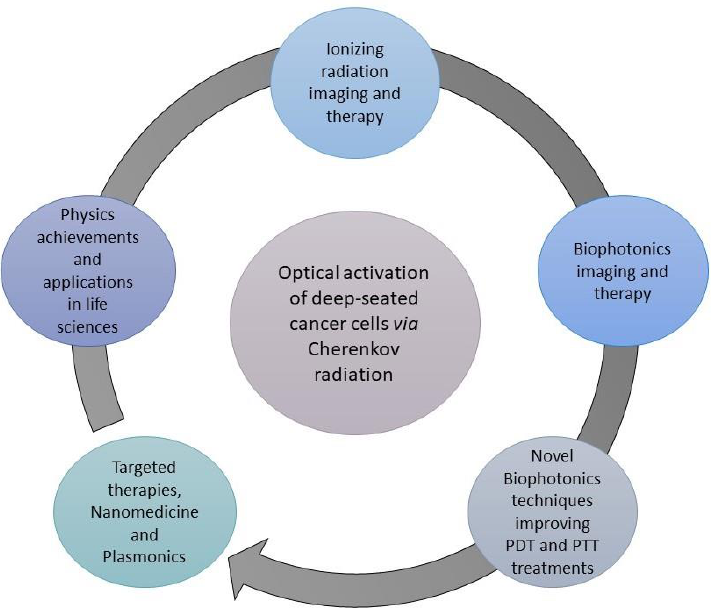
Figure 7. Schematic illustration of the interconnection of advanced radiation biophysics, biophotonic and nanotechnology techniques with the Cerenkov radiation for cancer management.